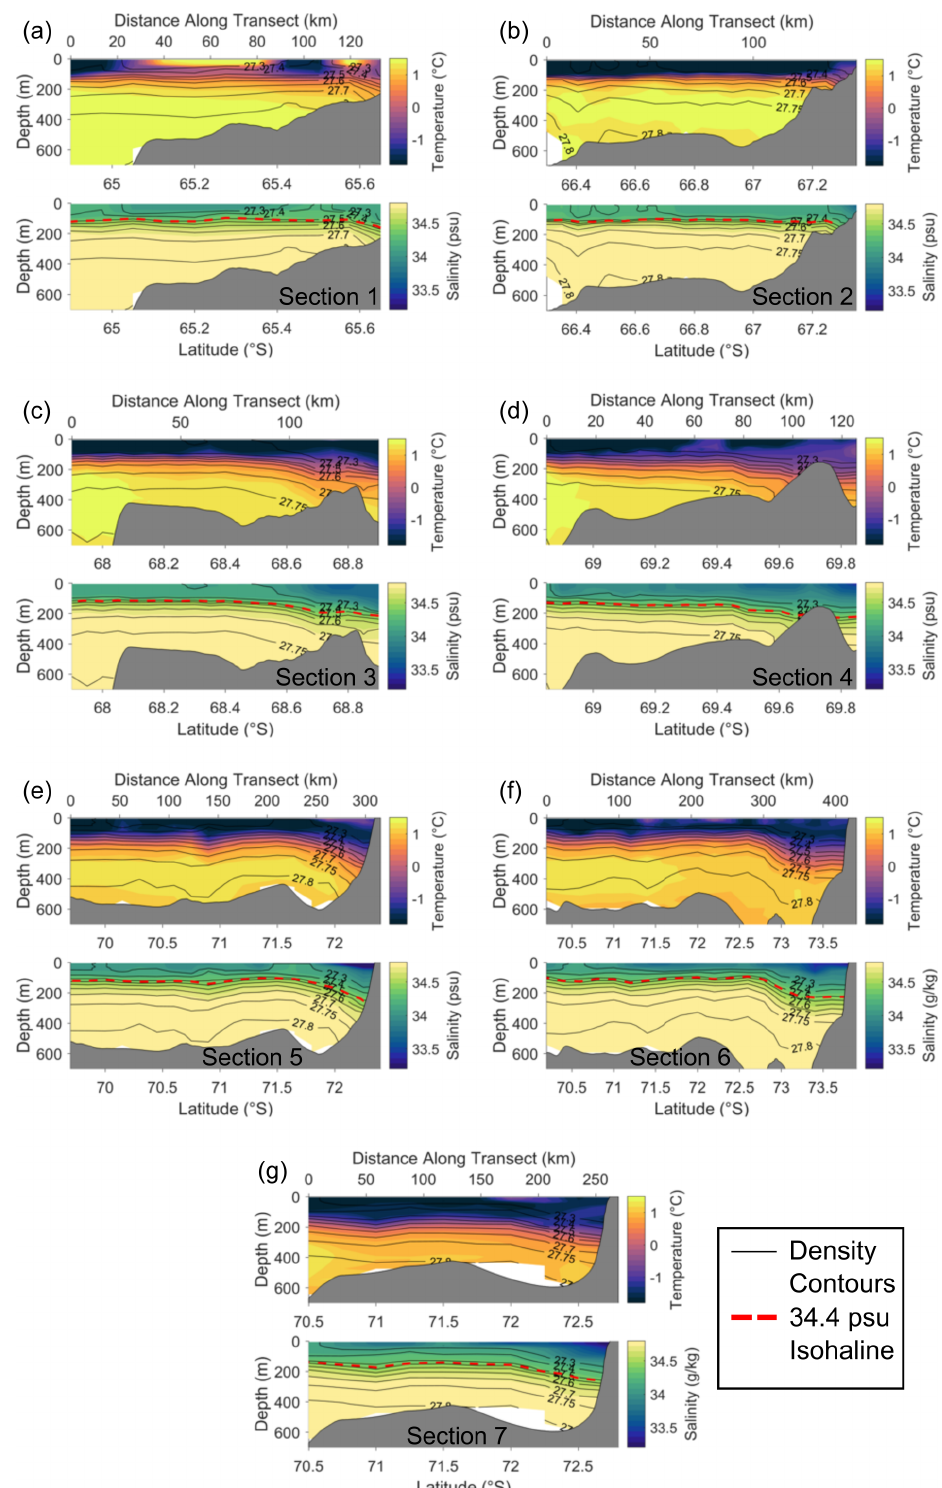
Figure 6. Vertical hydrographic sections of potential temperature (top) and salinity (bottom) in the upper 700m for each section in Fig. 3. Distance along the section is provided along the top of the temperature panels; note that sections are not of equal